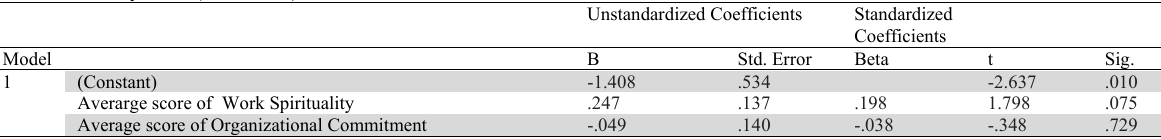
Heteroscedacity Test (Park Test)